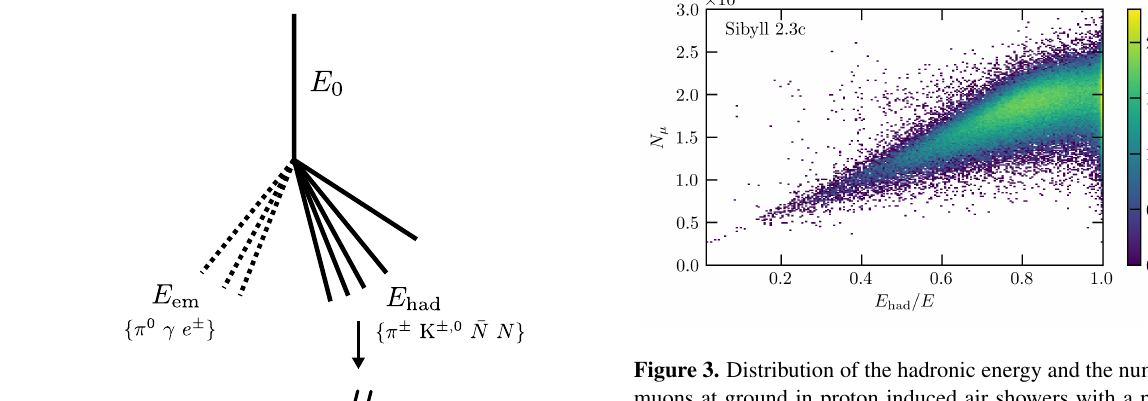
Figure 3. Distribution of the hadronic energy and the number of muons at ground in proton induced air showers with a primary energy of 10 19 eV.